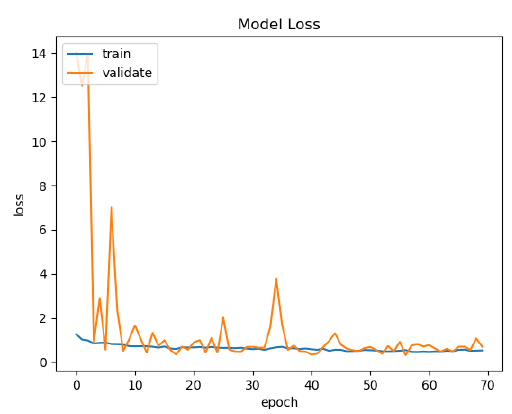
Figure 18. ResNet-SegNet Loss.